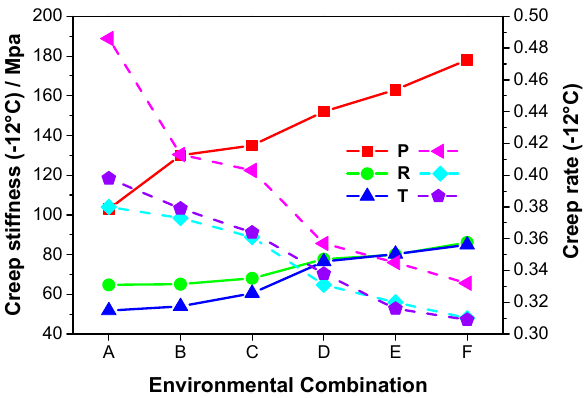
Figure 2. Creep stiffness and creep rate lines of three kinds of asphalts (P, R, and T) under different environmental combinations.